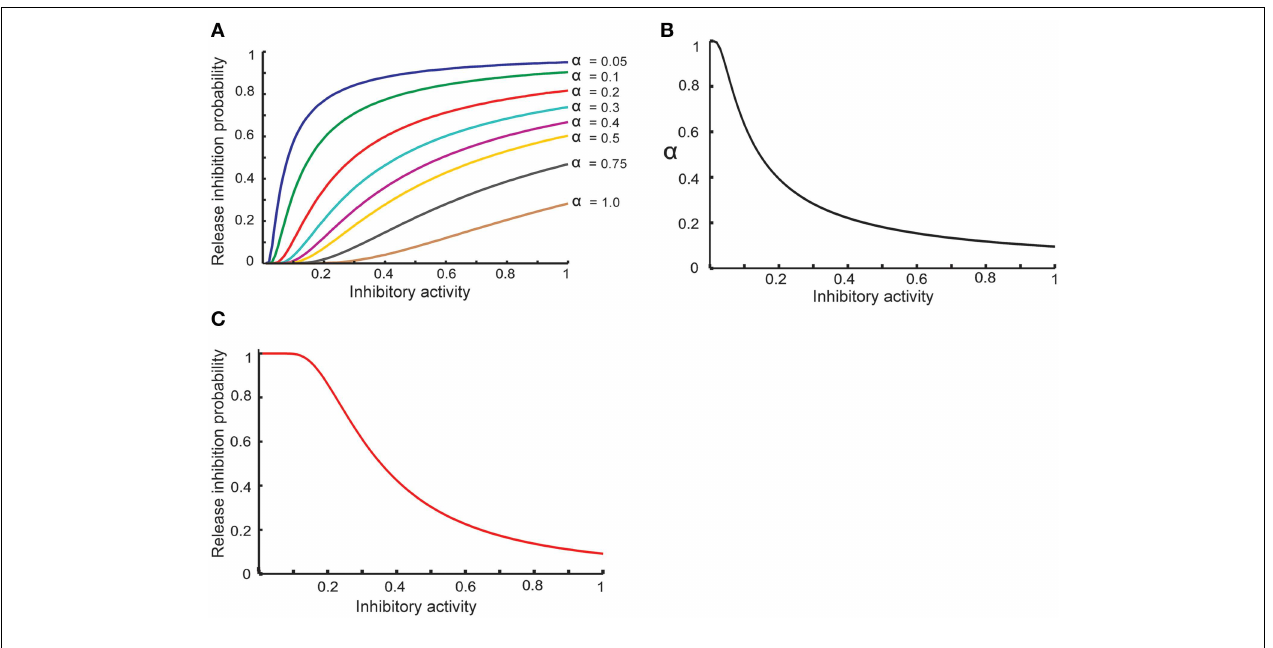
parameter ( α ) values. Higher inhibitory complex activity needs a lower α value while low inhibitory complex activity needs a higher α value. These observations motivated to define an exponential relationship between inhibitory complex activity and α value (B) which lead to non-linear relationship of inhibitory complex activity and release inhibitory probability (C)